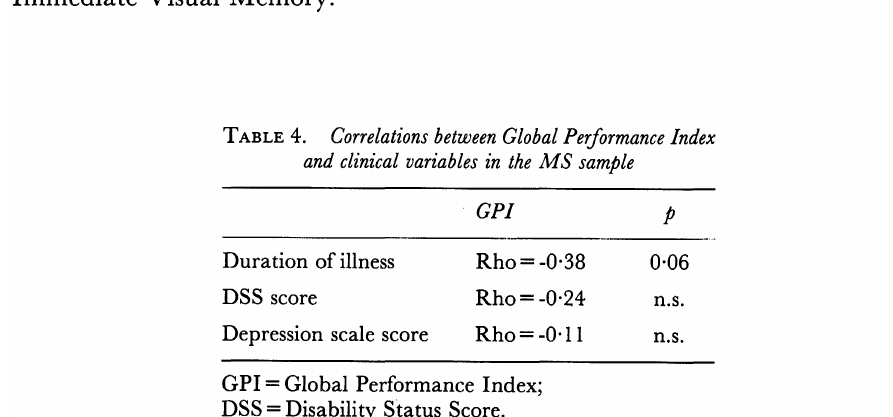
Correlations between Global Performance Index and clinical variables in the M S